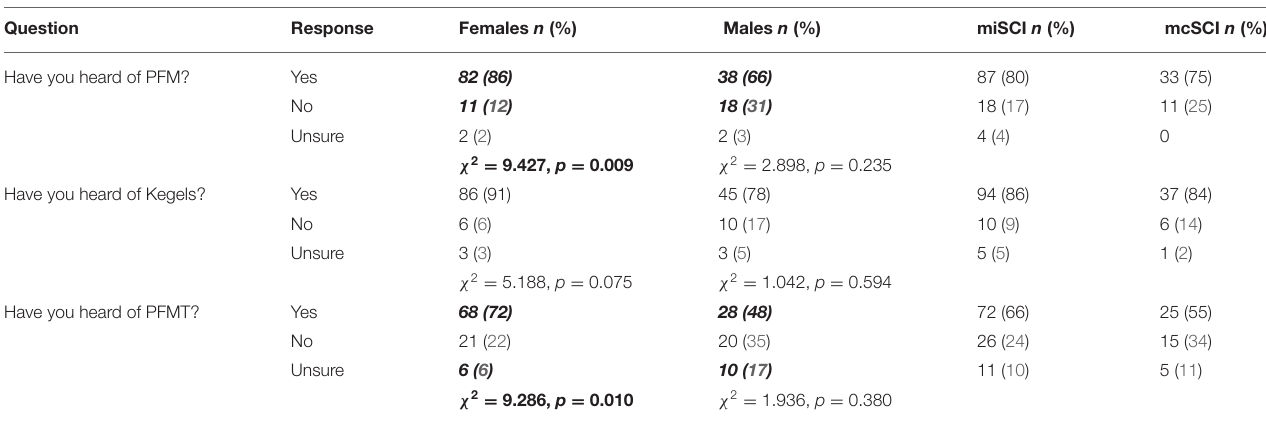
TABLE 2 | Knowledge results by sex and degree of motor function.